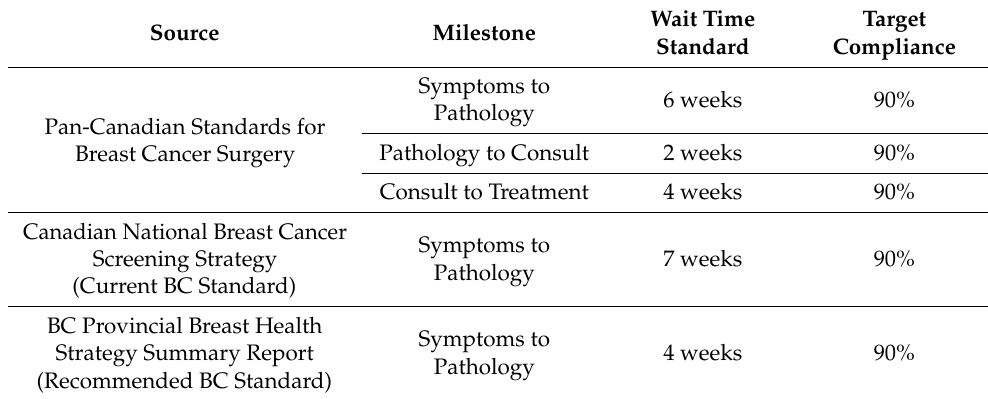
Table 1. Pan-Canadian and BC Provincial Wait Time Standards for Breast Cancer Diagnosis and Treatment.